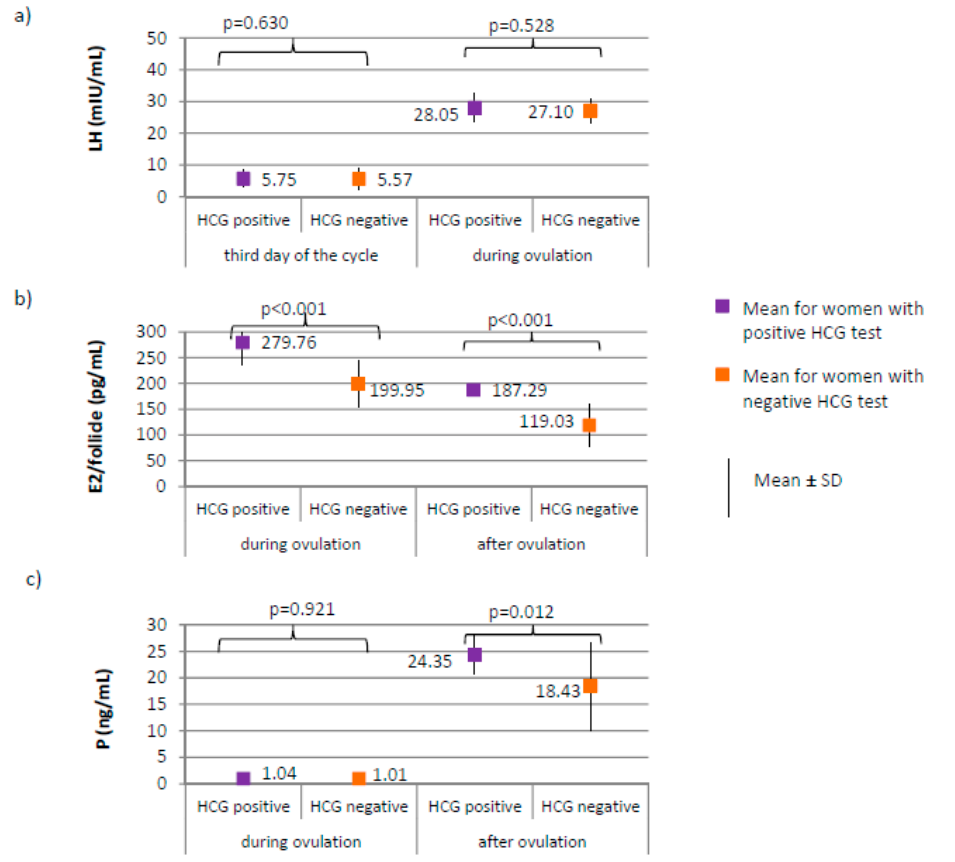
Figure 6. Comparison of LH (luteinizing hormone) ( a ), E2 (estradiol) ( b ), and P4 (progesterone) ( c ) women with positive HCG test ( N = 17) and women with negative HCG test ( N = 188).